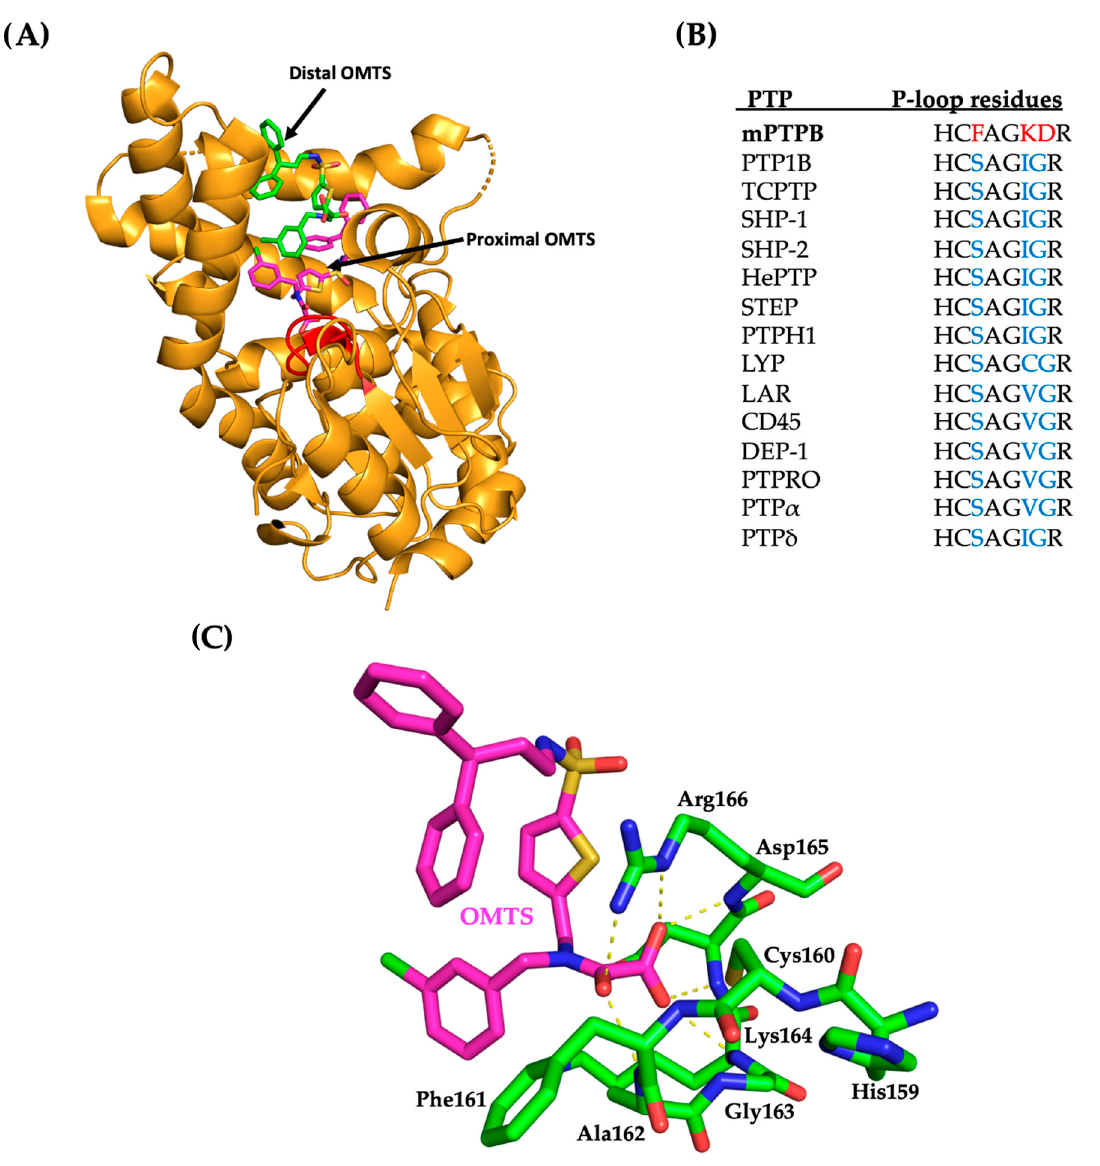
Figure 5. ( A ) The complex of mPTPB and OMTS (pdb code: 2OZ5) is shown in orange. The proximal and distal molecules of OMTS are shown in magenta and green, respectively. P ‐ loop residues 159HCFAGKDR166 are shown in red. ( B ) A comparison of P ‐ loop residues of mPTPB and other members of the PTP family. The residues in the P ‐ loop that make contacts to OMTS are shown in red and are unique in mPTPB compared to other PTPs (shown in blue color). ( C ) Molecular interactions between proximal OMTS (in magenta) and P ‐ loop residues (in green) in mPTPB (pdb code: 2OZ5). Hydrogen bonding interactions shown as yellow dotted lines.